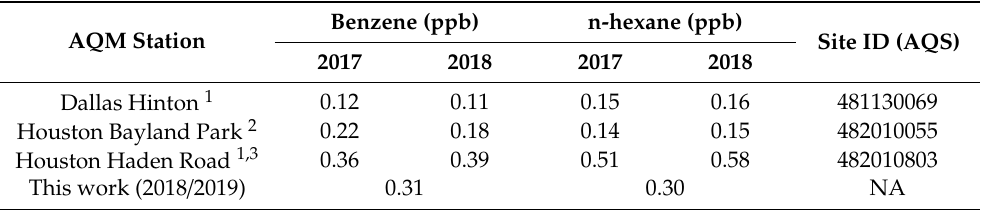
Table 2. Average annual volume mixing ratios of benzene and n-hexane measured at urban air quality monitoring (AQM) stations in Texas compared to rural results in this